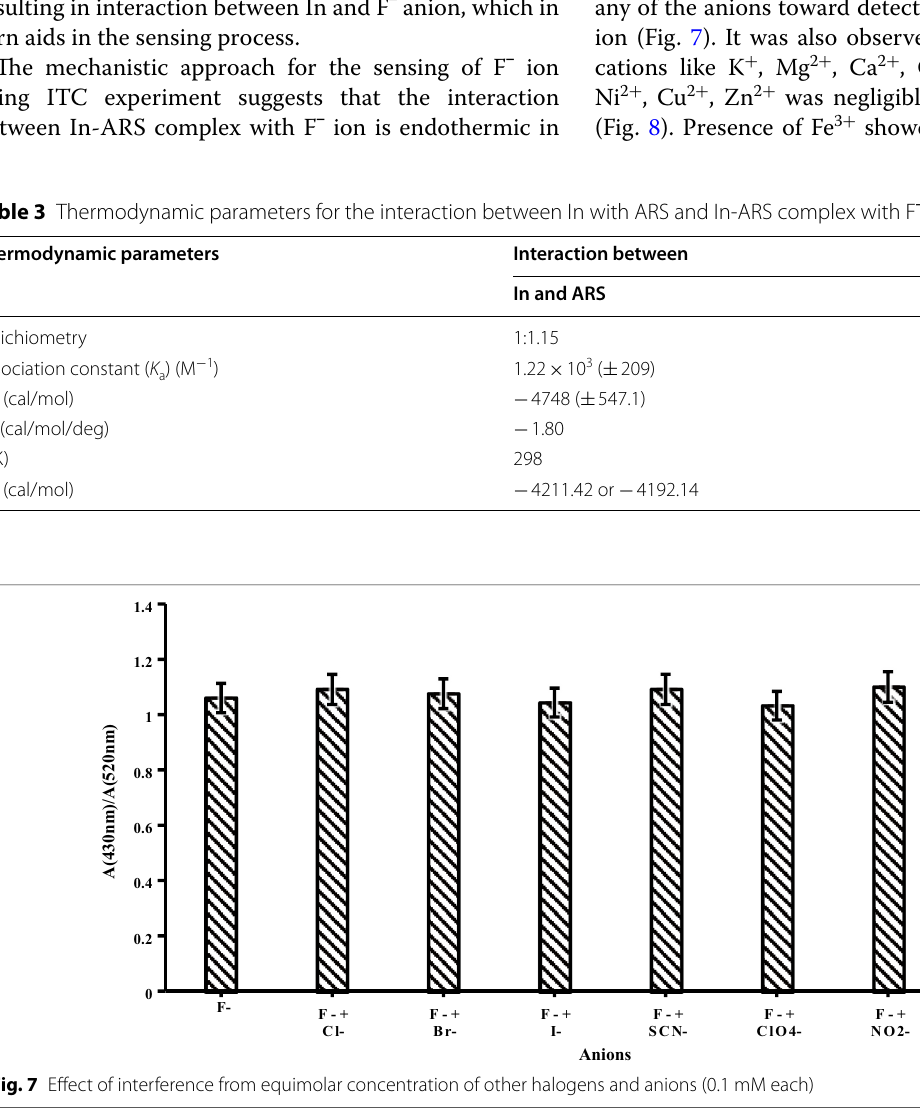
Fig. 7 Effect of interference from equimolar concentration of other halogens and anions (0.1 mM